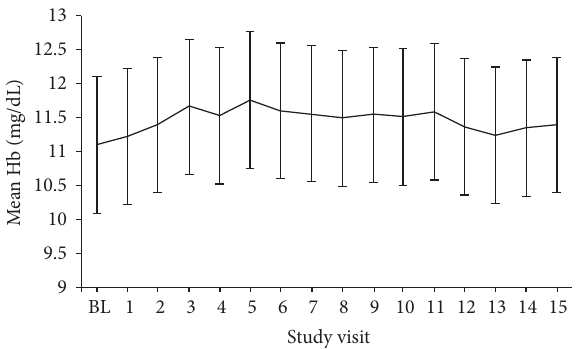
Figure 2: Hb level (efficacy population, 𝑛 = 191 ). Values are shown as mean (SD). BL: